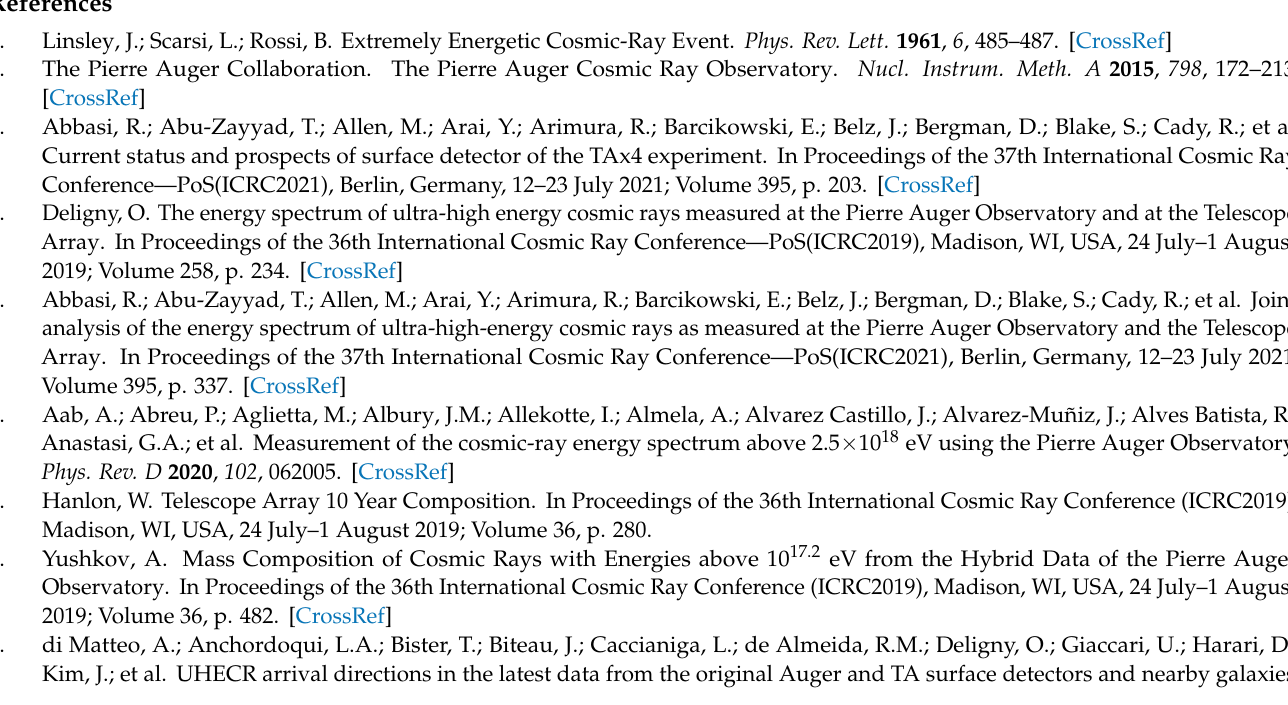
An S-curve is a dependence of the ASIC count rate vs. threshold, so it is a cumulative distribution function of single photoelec- tron pulses. The function used here is the so called Gaisser–Ilina–Linsley (GIL) function. Simulations are being updated to include more up to date parameterizations and MC shower simulators as